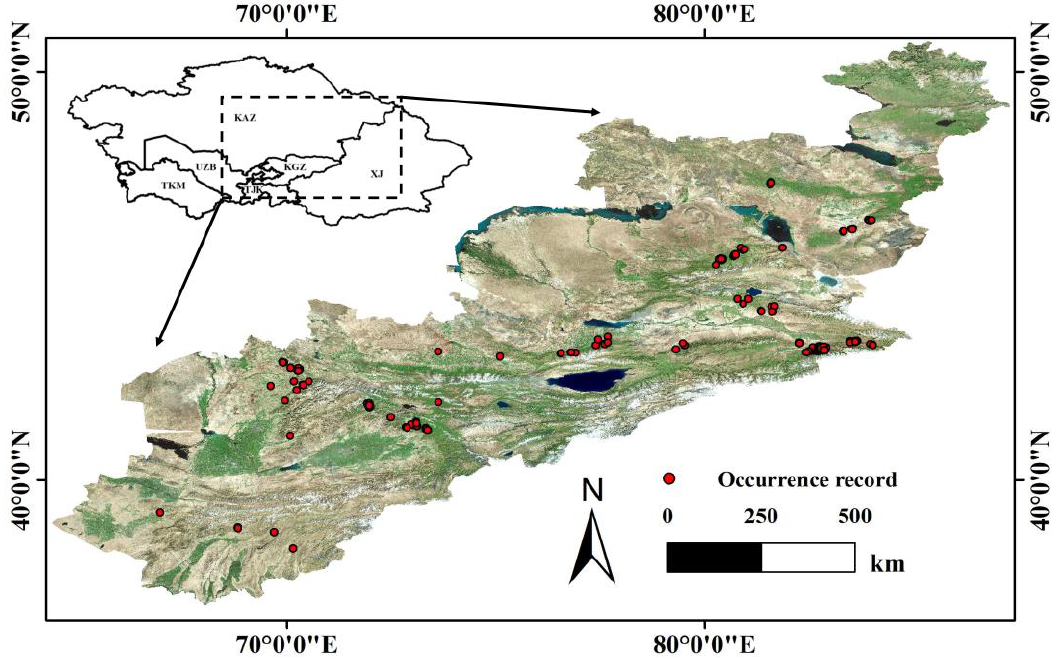
Figure 1. Location of the study area in Central Asia. XJ: Xinjiang, China, KAZ: Kazakhstan, KGZ: Kyrgyzstan, TJK: Tajikistan, UZB: Uzbekistan, TKM: Turkmenistan. Red points represent occurrence records for wild apple.